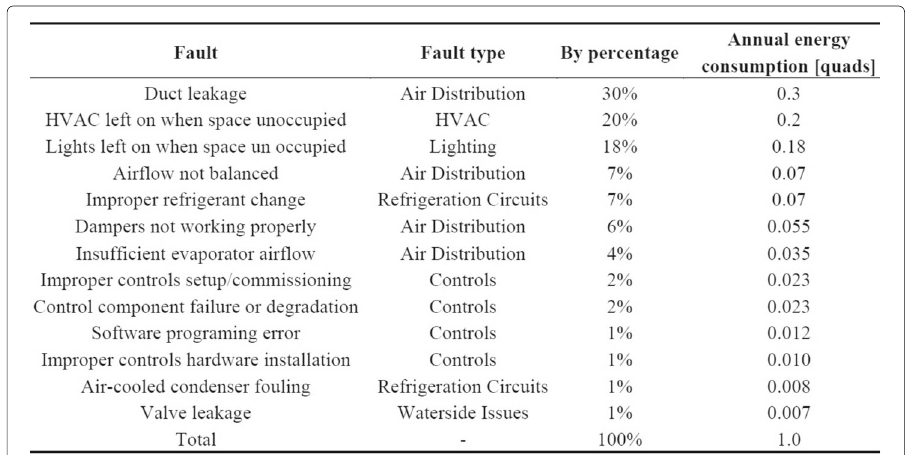
Fig. 2 The annual impact of faults in terms of energy consumption (Roth et al.